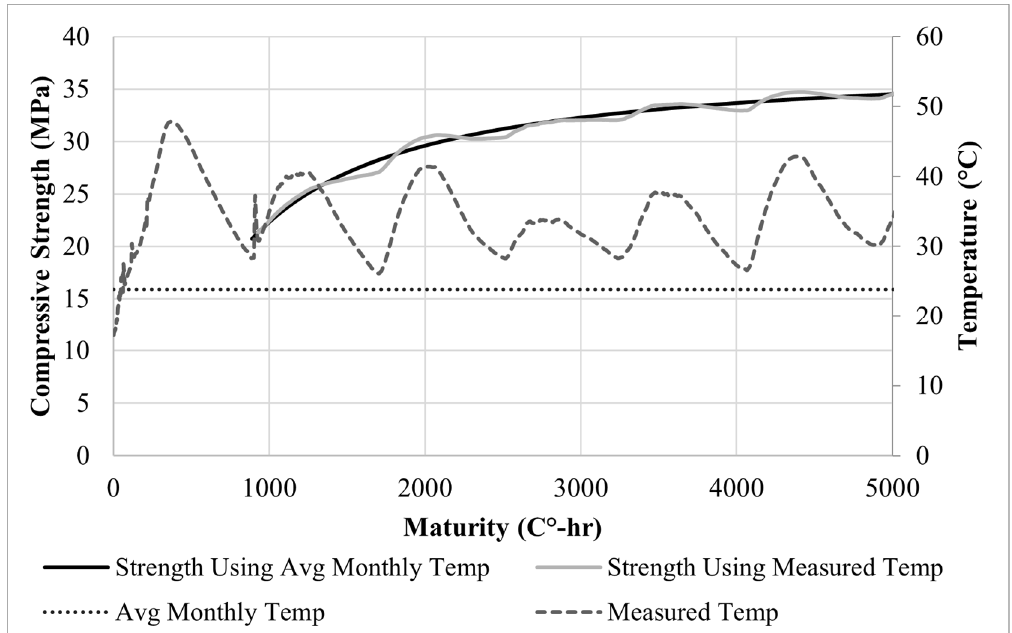
Figure 5. Using different temperature to determine the maturity–strength relationship after a strength of 20.7 MPa.